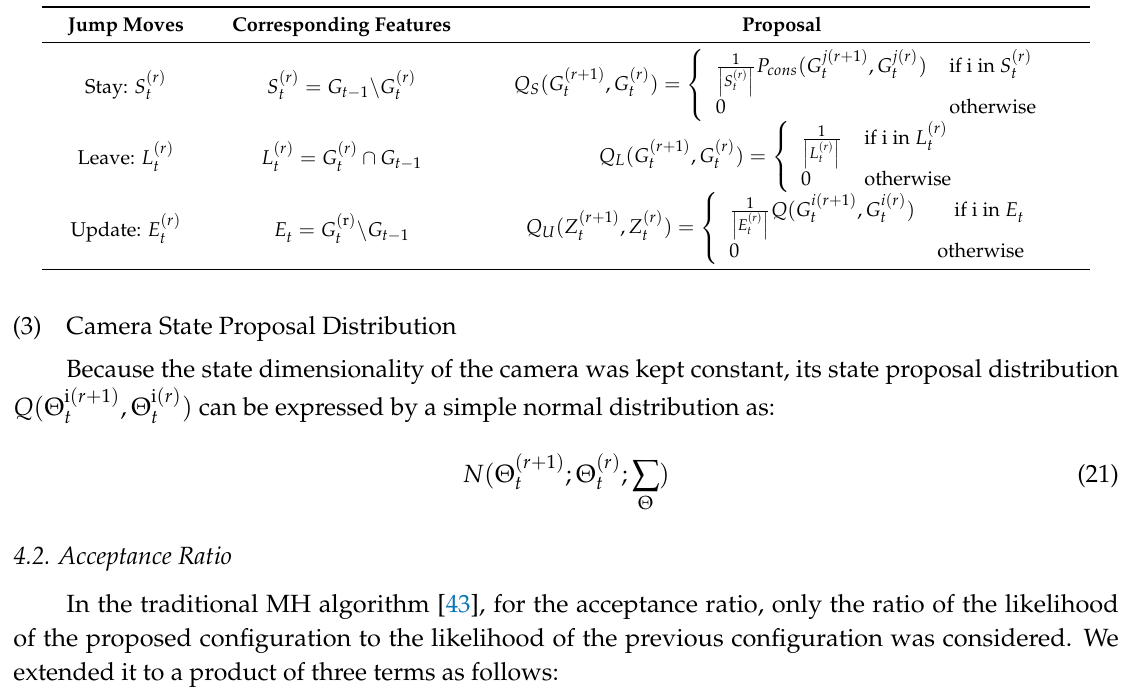
Table 2. The proposal of geometric features’ jump